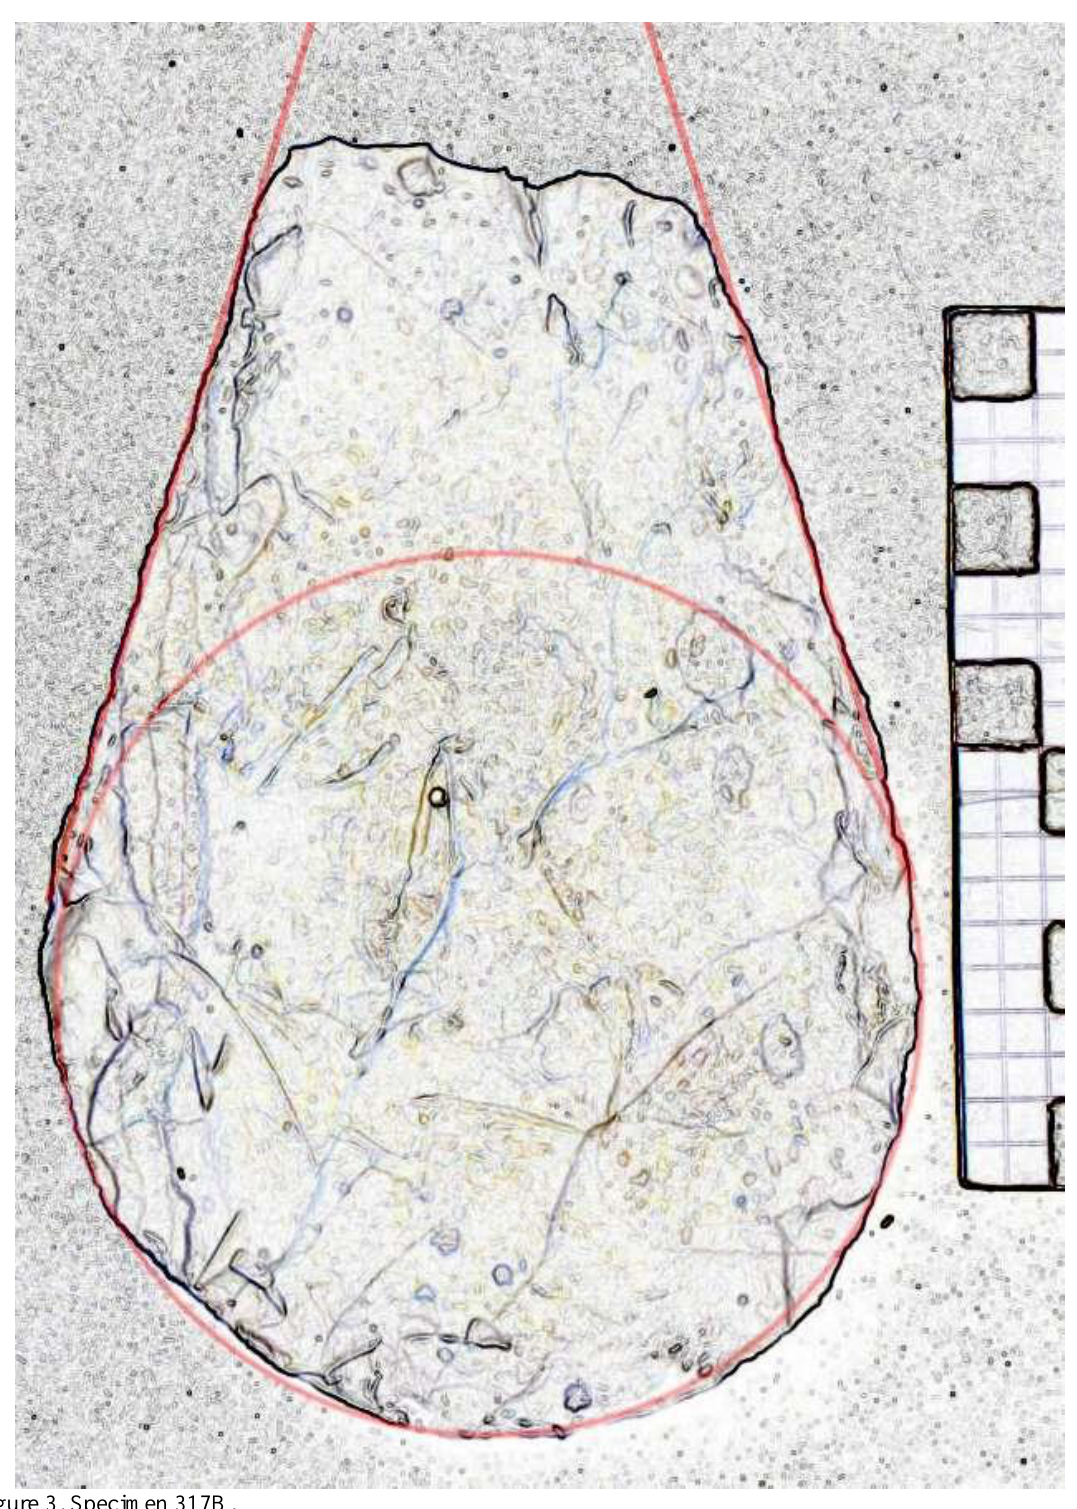
Figure 3. Specimen